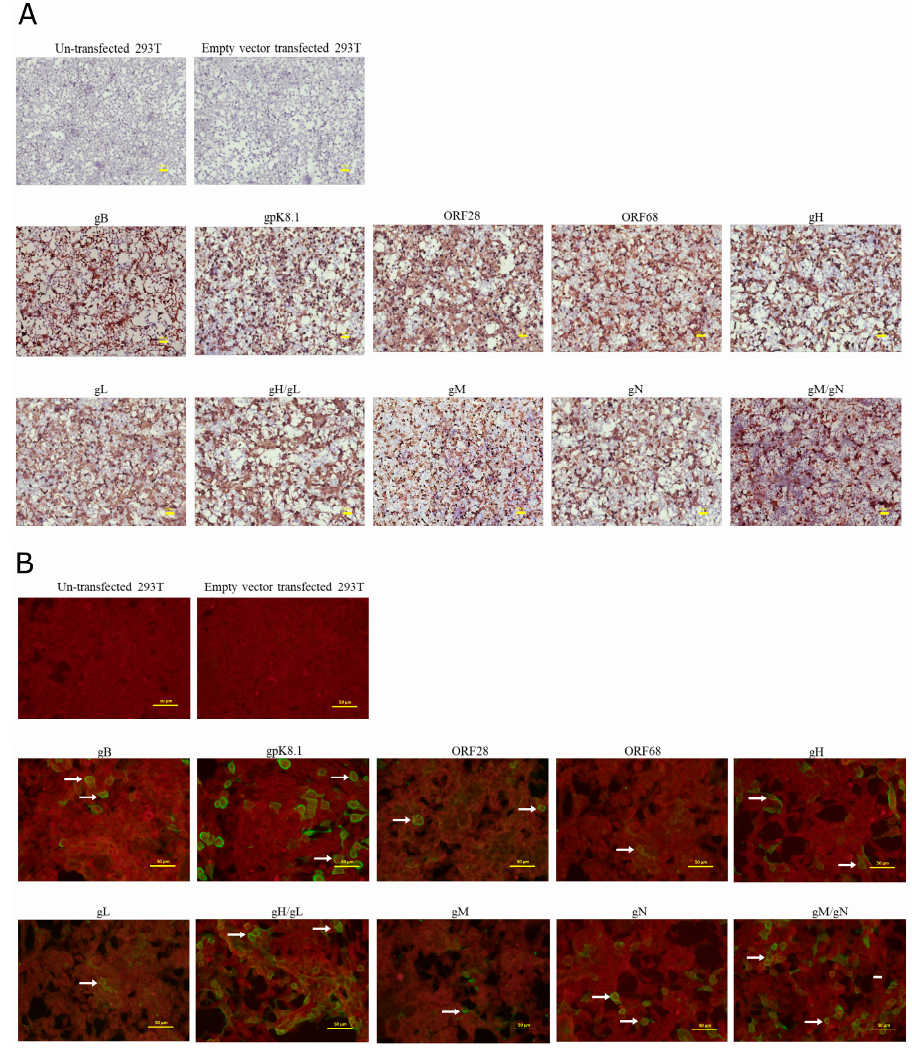
Figure 2. KSHV envelope glycoproteins expression in 293T cells by immunohistochemistry IHC and immunofluorescence assay (IFA). ( A ) KSHV glycoproteins expression was confirmed in 293T cells at 72 h post-transfection by IHC against the 3xFLAG tag. Positive cells are stained brown. ( B ) The cell surface expression of KSHV glycoproteins was confirmed by IFA on nonpermeabilized 293T cells at 72 h post-transfection with pooled plasma from all study participants. Positive cells are indicated by white arrows. Pictures were taken at 20X